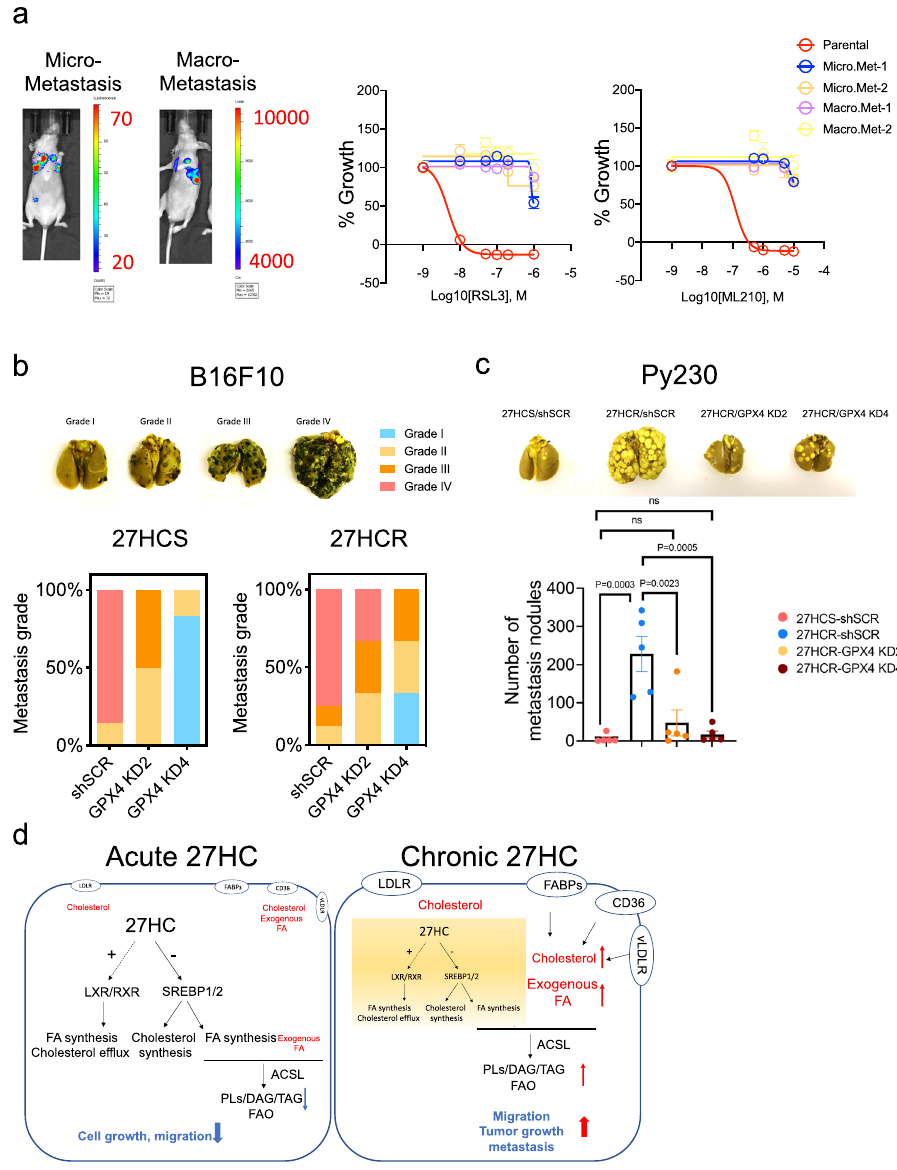
Fig. 5 GPX4 inhibition sensitizes 27HCR cells to ferroptosis and reduces their metastatic capability. a A total of 2 × 10 5 luciferase labeled Py230-27HCS and -27HCR cells were injected intravenously into nude or C57/BL6 mice. After 2 months, Py230-27HCS cells developed micrometastasis and Py230- 27HCR cells formed overt macrometastasis. Bioluminescent images of lung metastasis as shown in the left panels. Metastatic tumor cells were then recovered from lungs and propagated as cell lines (Micrometastasis: Micro. Met1 and 2 and Macrometastasis: Macro Met1 and 2). Py230 parental and lung metastasis derivative cell lines were treated with GPX4 inhibitors, RSL3 (middle), and ML210 (right) for 48 h, followed by cell proliferation assay. Relative cell growth (% of Growth) was calculated by normalizing each treatment condition to control-treated wells. Data plotted as mean ± SEM from fi ve technical replicates. b 2 × 10 5 GPX4 wild-type (shSCR) and knockdown (KD2 and KD4) B16F10-27HCS and -27HCR cells were injected intravenously into C57BL/6 mice ( n = 5 mice). Lung metastases were graded and scored when mice were euthanized on Day 16. Representative images of lung tissue used for grading are shown in the upper panel. c 3 × 10 5 GPX4 wild-type (shSCR) and knockdown (KD2 and KD4) Py230-27HCR cells, as well as GPX4 wild- type (shSCR) Py230-27HCS cells were injected intravenously into C57BL/6 mice ( n = 5 mice). Lung metastases were quanti fi ed when mice were euthanized on Day 40. Representative lung images are shown in the upper inset. Data plotted as mean ± SEM; P values were calculated using two-way ANOVA. d The proposed model to explain how cancer cells respond to 27HC treatment. Acute (left) treatment with 27HC disrupts lipid metabolism via interfering with SREBPs and LXR signaling, and this results in the inhibition of cell growth and migration. Cancer cells can adapt to the metabolic stress imposed by chronic treatment by 27HC (right). The cells that survive (27HC resistant cells) increase lipid uptake and accommodate the metabolic stress associated with this activity by upregulating the activity of processes that allow them to withstand lipid oxidative stress (ferroptosis); an activity which confers upon them enhanced tumor growth and metastatic capabilities. Numerical source data are reported in the Source Data